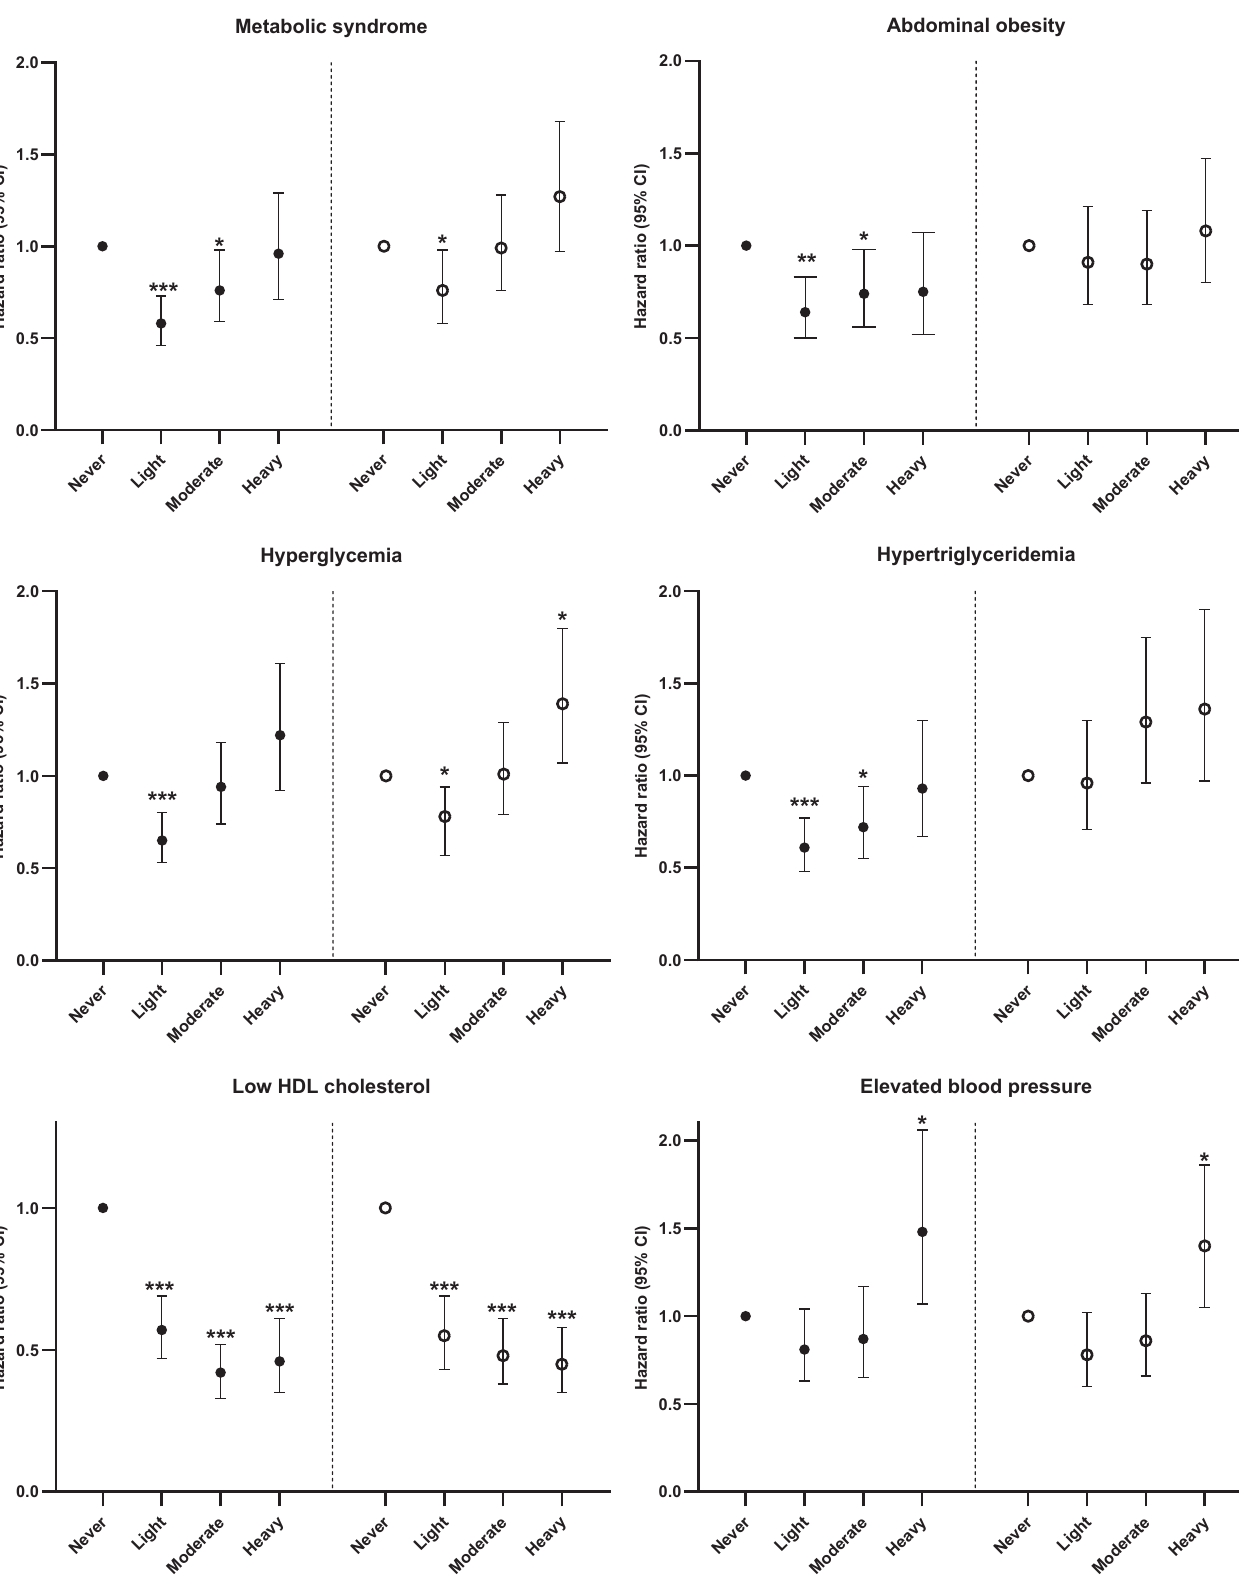
Figure 1. Hazard ratios (HRs) and 95% con fi dence intervals (CIs) for incident MetS and its components according to alcohol consumption by smoking status in men. Closed circles, non-smokers; open circles, current smokers. Multivariate Cox proportional hazards model was adjusted for age, residential location, household income, education level, physical activity, BMI, energy intake, fruit intake, meat intake, re fi ned grain intake, whole grain intake, and dairy